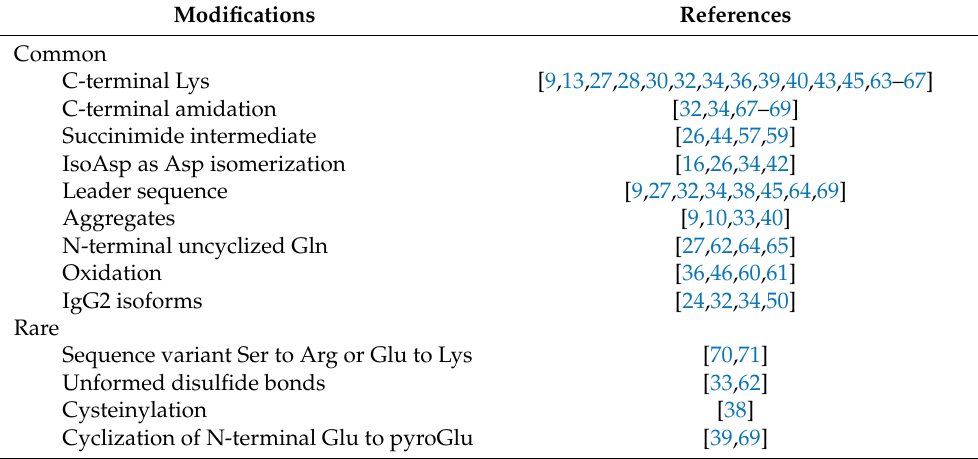
Table 2. Modifications in basic